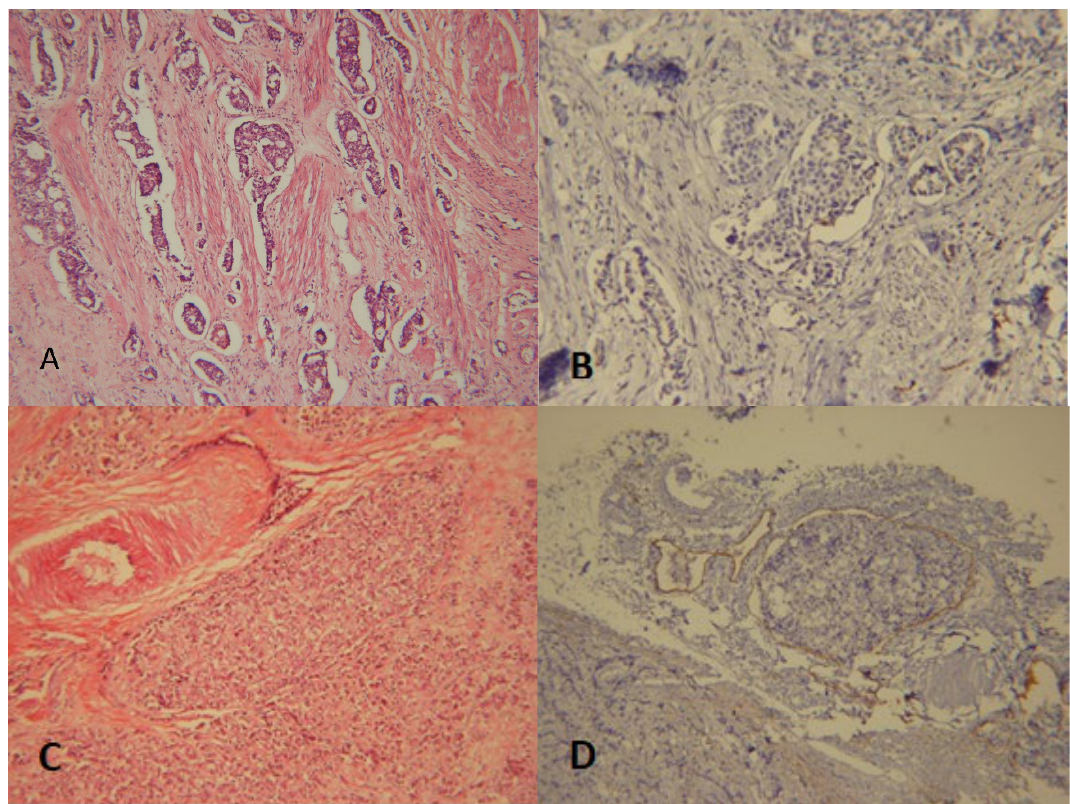
Fig. 1. A. Retraction artifact (H&E method x100). B. Retraction artifact proved by D2-40 IHC (x100). C. Tumor emboli filling the lumen (H&E method x100). D. Tumor emboli proved by D2-40 IHC method